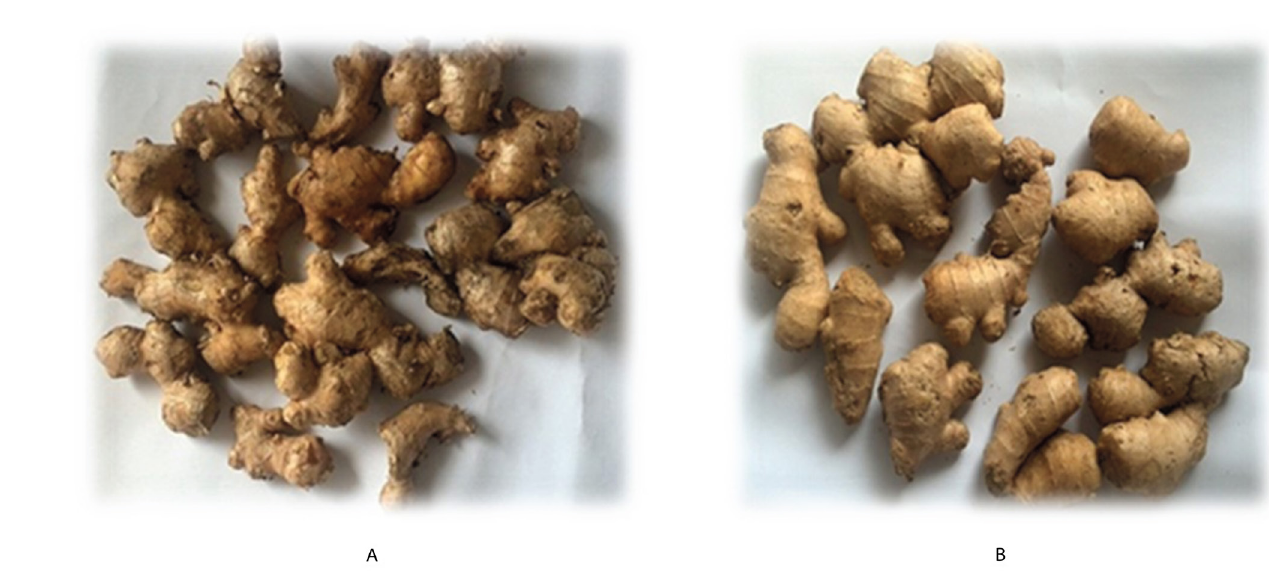
FIGURE 1 - (A) Pakistani ginger and (B) Chinese